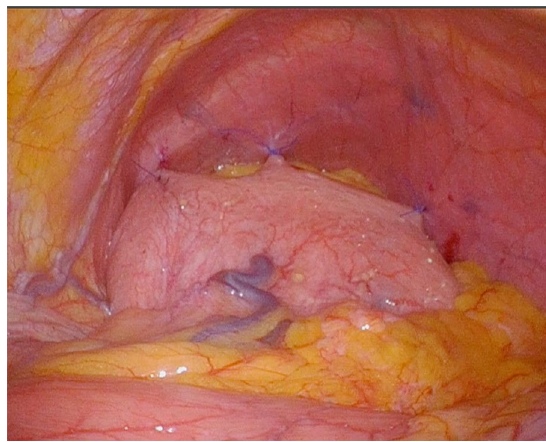
Fig. 5 The gastric fornix was sutured to the left diaphragm